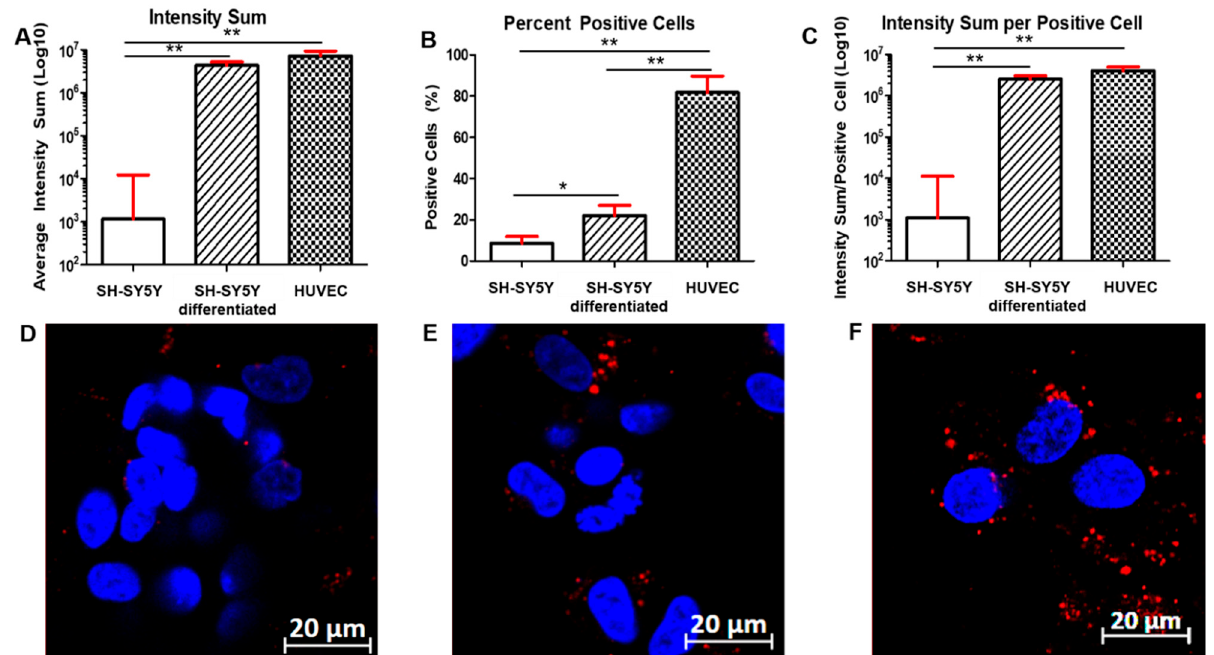
Figure 4. Entry of PV-SARS-CoV-2-S-(D614G)-VSV- (cid:52) G-mCherry in SH-SY5Y ( A – D ), RA-differentiated SH-SY5Y cells ( B – E ), and HUVEC cells ( C – F ). Upon infection with the pseudovirus carrying the Spike with the D614G mutation, images were acquired after 24 h post-infection. The average intensity sum of the signal ( A ), the number of positive cells ( B ), and the average intensity sum of the signal/positive cell ( C ) were calculated for both SH-SY5Y and RA-differentiated SH-SY5Y and HUVEC cells. Results represent the mean and SEM of 10 different locations in each well. Representative images of SH-SY5Y cells ( D ), RA-differentiated SH-SY5Y cells ( E ), and HUVEC cells ( F ) show the viral entry. DAPI-staining was used for nuclei detection. Scale bar: 20 µ m. * p < 0.05 and ** p < 0.01, calculated using a two-tailed Student’s t -test. A representative of three different experiments is